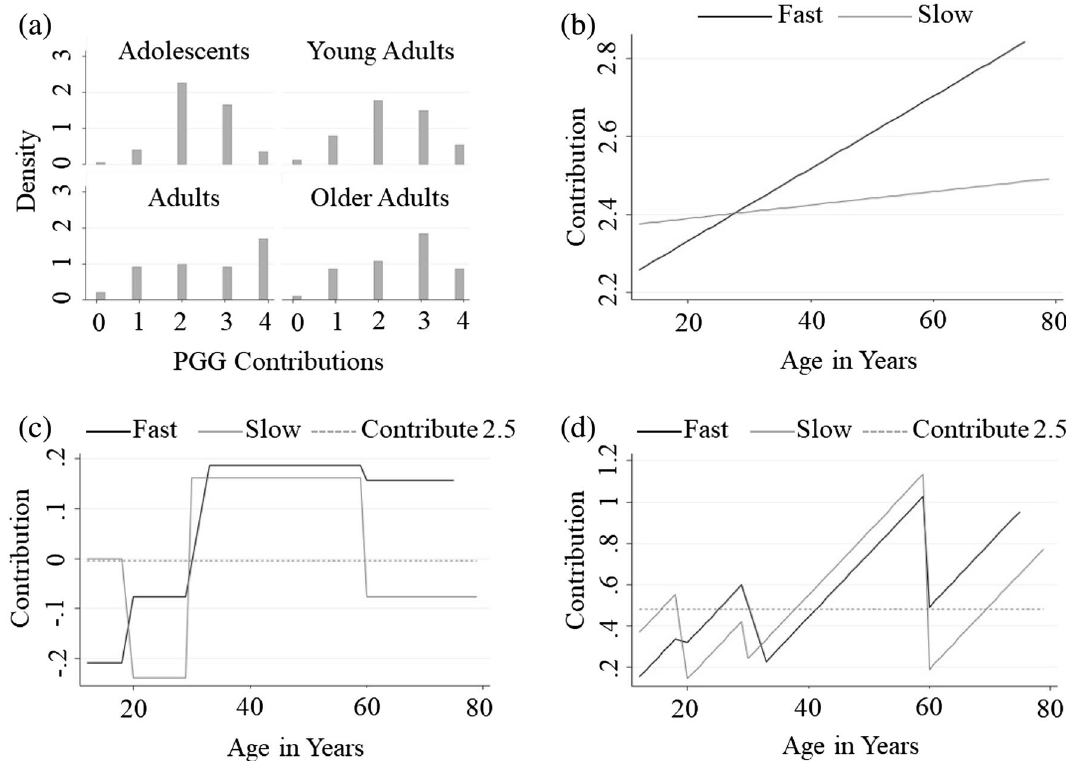
Figure 1. Participants’ Choices in the Public Goods Game . Panel ( a ) reports the frequency of contribution within the four age groups across conditions. Participant contributions increase across the lifetime only to taper off in older adults. Panel ( b ) depicts the OLS estimation of specification (1) with the black line representing estimated contributions under time-pressure (fast), and the grey line representing estimated contributions under time-delay (slow). Panels ( c ) and ( d ) depict the ordered Probit regressions by age group from Eqs. (2) and (3) with black lines depicting expected contribution under time-pressure and grey lines depicting contributions under time-delay. In both panels, the dependent variable is rescaled by the ordered Probit approach, and the dashed line represents a contribution of 2.5 lottery